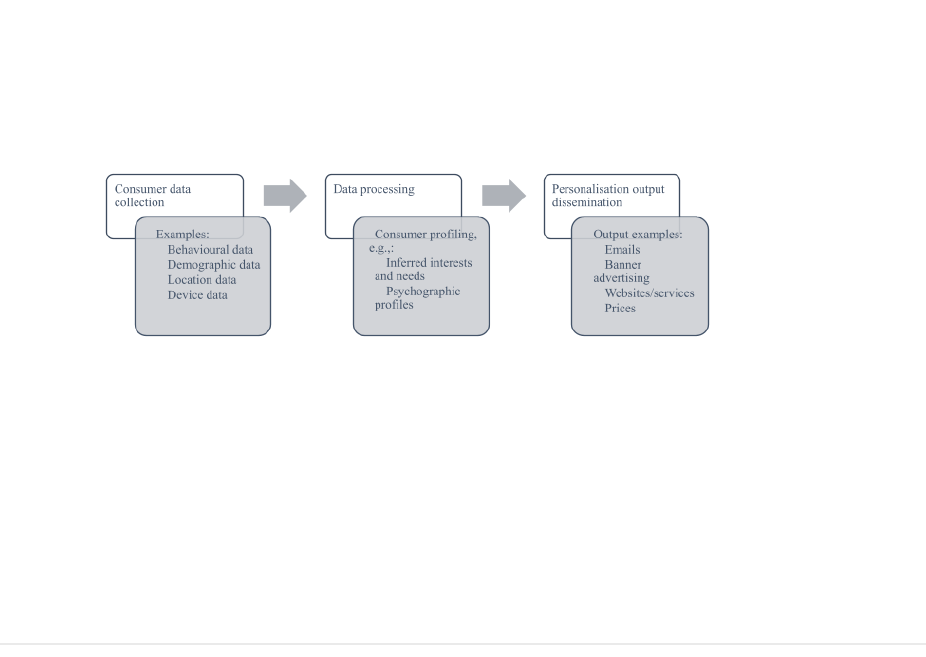
FIGURE 1: Three stages of PMC. Source: by the